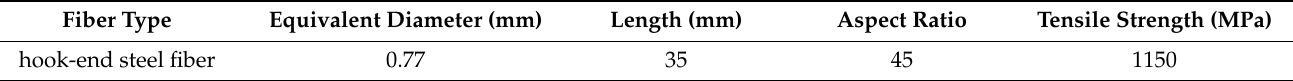
Table 2. Physical mechanical performance index of the steel fibers.